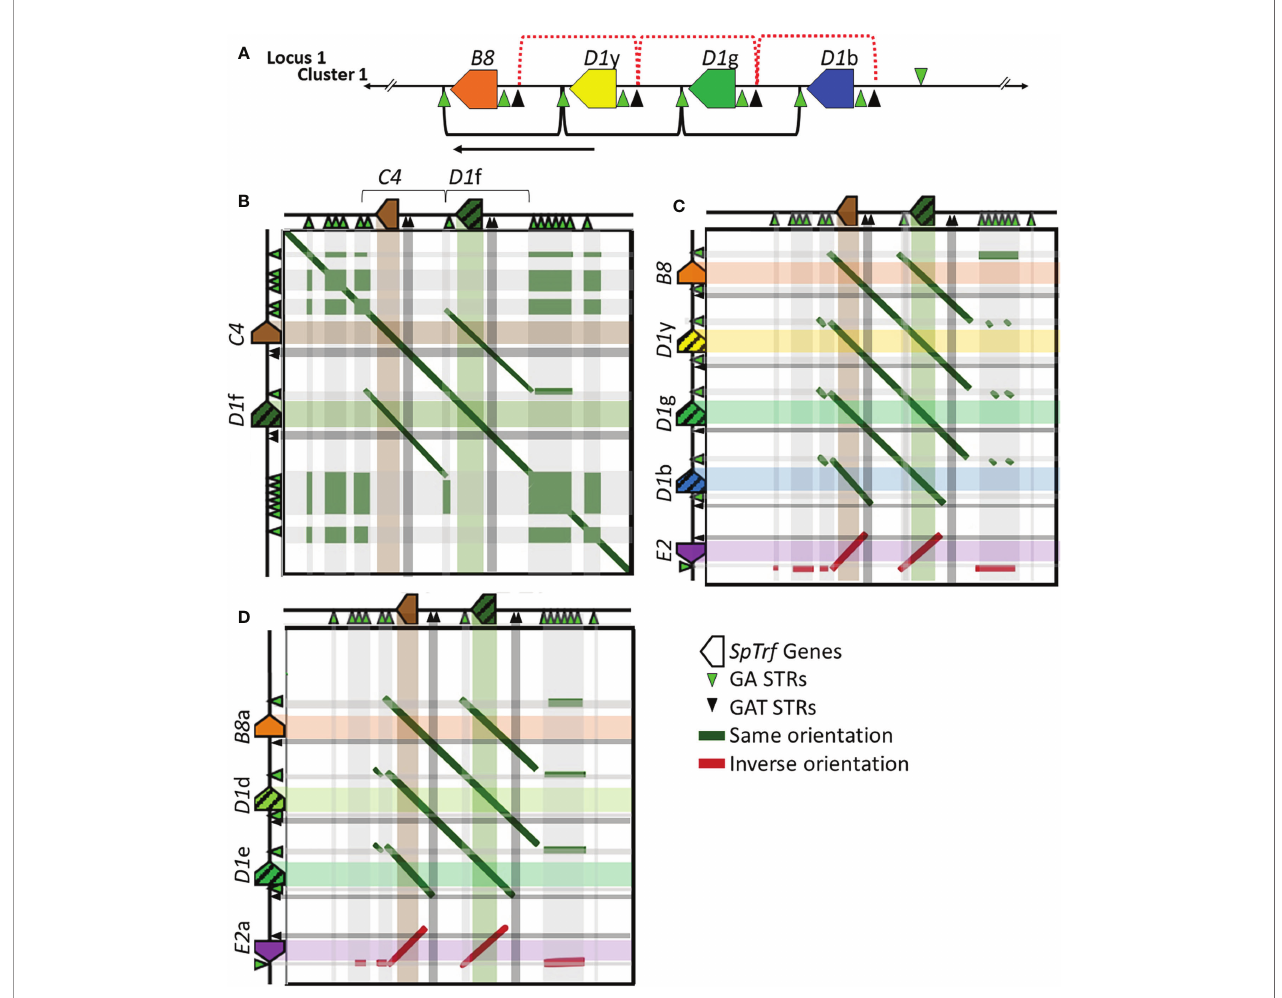
FIGURE 6 | Representative dot plots of Cluster 3 compared to other SpTrf clusters indicates that the GA STRs are the likely edges of the segmental duplications in both loci. (A) A portion of Cluster 1 shows the region with the segmental duplications and the D1 genes. The previously reported D1 segmental duplications are indicated at the top of the fi gure [red dotted brackets (30)] and the revision to the proposed segmental duplications are indicated on the bottom (black brackets). The arrow indicates the directional shift of the proposed edges of the segmental duplications. (B – D) Representative images of a gene cluster or portion of a gene cluster are located to the left and top of each dot plot. Colored polygons indicate genes and transcriptional direction. Green triangles represent GA STRs and black triangles represent GAT STRs. The central diagonal in (A) shows the main alignment of cluster 3 against itself, while lines that are offset from the central diagonal in all dot plots indicate the locations of repeats or highly similar regions. Diagonal dark green lines indicate similar regions in the same orientation whereas, dark red solid lines indicate regions of inverse orientation. The highlighted horizontal and vertical lines of multiple colors (matching to the genes at the top or side) are added to the dot plots to illustrate the location of matched sequences. Dark green areas indicate the locations of GA STRs and dark gray areas indicate the locations of the GAT STRs. (B) Cluster 3 vs . Cluster 3. (C) Cluster 3 vs . a subset of genes in Cluster 1. (D) Cluster 3 vs . a subset of genes in Cluster 2. YASS 8 was used to generate dot plots with standard parameters (scoring matrix = +5, -4, -3 -4: composition bias correction: gap costs = -16, -4: e-value threshold = 10: X-drop threshold =